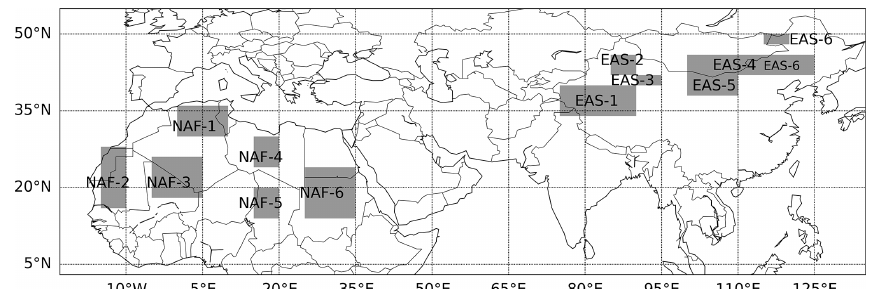
Figure 12. Six dust potential source subregions in Northern Africa (NAF) and Eastern Asia (EAS) based on Figs. 1 and 2 in Formenti et